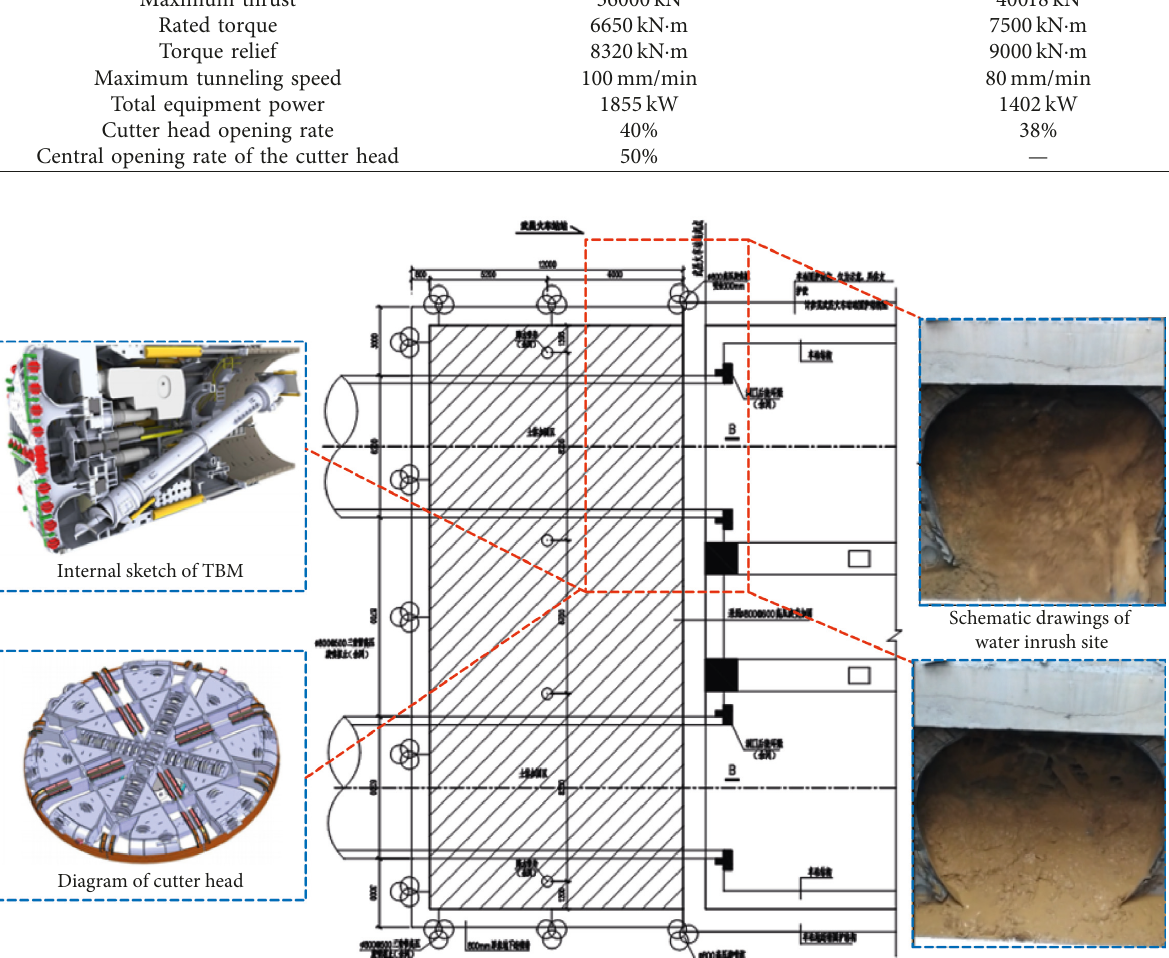
Figure 2: Schematic diagram of the surge accident scene in the shield arrival stage at the Wuchang railway station.